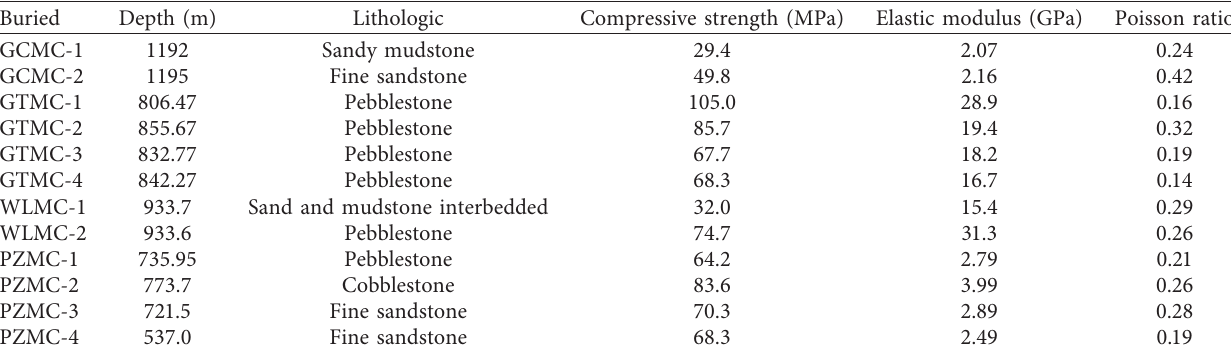
Figure 1: Schematic diagram of stress relief Table 1: Relative situation of each measurement point of in situ stress.